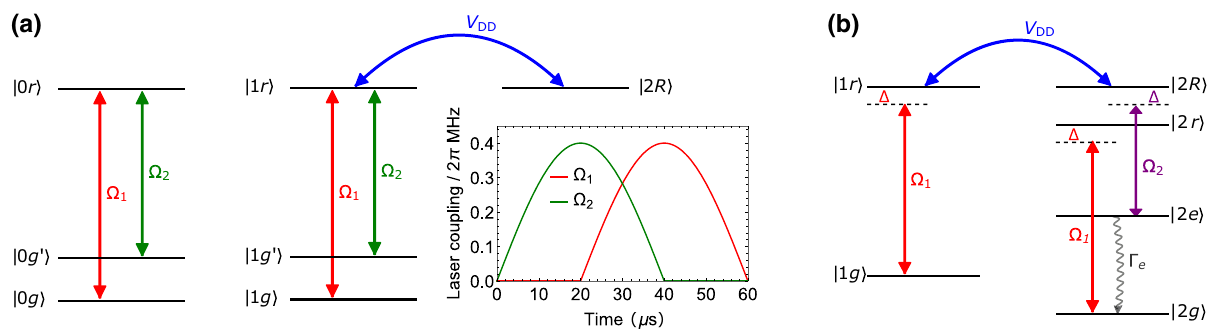
FIG. 5. (a) Qubit readout. The atom has two hyperfine ground states | g (cid:2) and | g (cid:5) (cid:2) . Two laser fields, (cid:3) 1 and (cid:3) 2 , couple | g (cid:2) ↔ | r (cid:2) and | g (cid:5) (cid:2) ↔ | r (cid:2) , respectively. The STIRAP pulse sequence shown in the plot is applied. The atom initially in | g (cid:2) is adiabatically transferred to | g (cid:5) (cid:2) when the molecule is in | 0 (cid:2) (left), but this transfer is suppressed by the dipole-dipole interaction (blue arrow) when the molecule is in | 1 (cid:2) . Subsequently, the state of the atom is read out using a fluorescence measurement. (b) Qubit initialization. Two laser fields (cid:3) 1 and (cid:3) 2 couple | g (cid:2) ↔ | r (cid:2) and an excited state (not a Rydberg state) | e (cid:2) ↔ | R (cid:2) with the same detuning. We first map | 0 (cid:2) to | 2 (cid:2) . The state